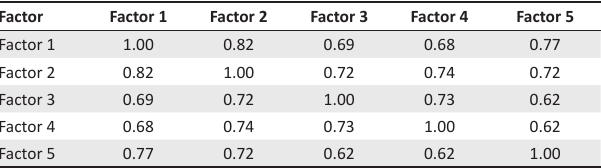
TABLE 3: Correlation among extracted factors.